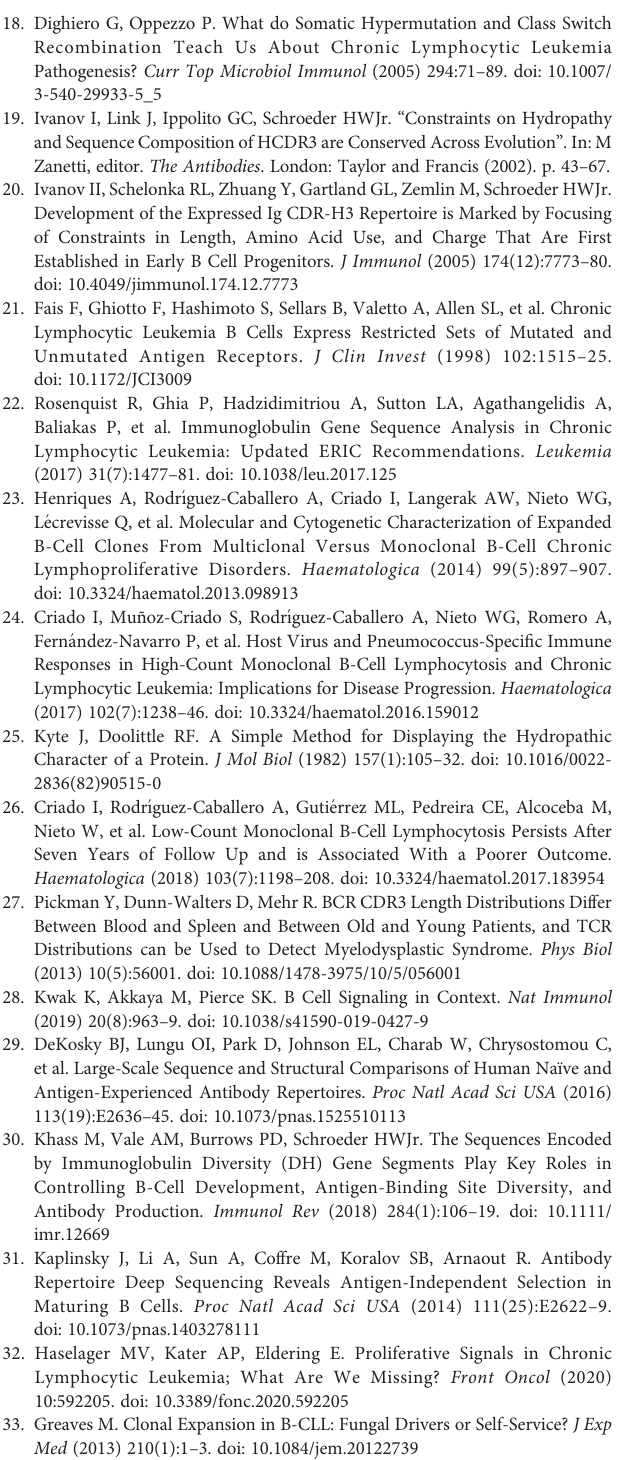
Supplementary Figure 1 | Kyte-Doolittlenumericalscaleofaminoacids(aa)andthe formulato calculatethe GravyScore (GS)ofHCDR3 (hydropathyindex). The biochemicalnatureofaaaccordingtotheirKyte-Doolittlevalueandthealgorithmused to calculatethe GS of the HCDR3 sequence in ourpatients are shown in (A, B)